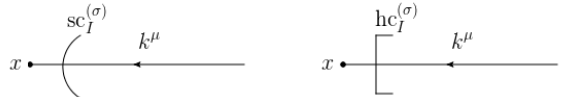
Figure 2. Pictorial representations for the soft-collinear and hard-collinear approximations pro- vided by t (cid:27) . After being projected by the approximations, the momenta (cid:13)owing into the vertex x (cid:22) (cid:0) (cid:1) are ( k (cid:1) (cid:12) I ) (cid:12) and k (cid:1) (cid:12) (cid:12) (cid:22) I I I